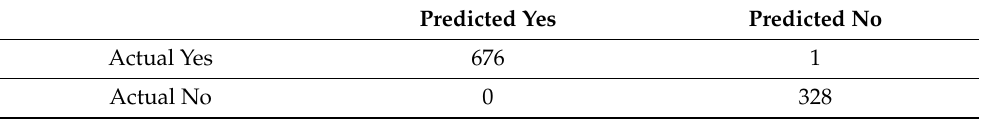
Table 16. SVM confusion